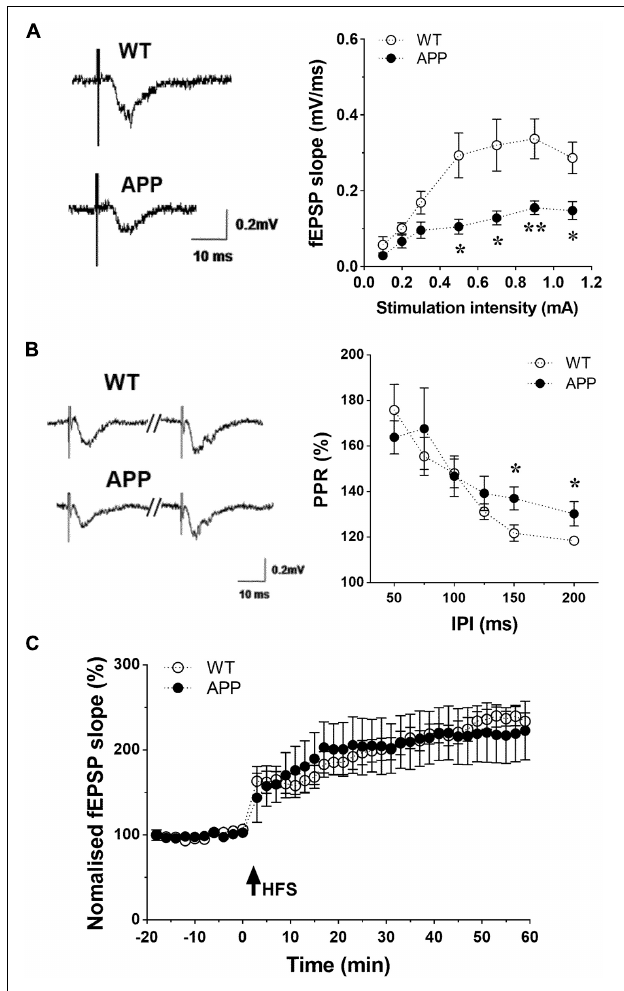
FIGURE 7 | Impaired hippocampal synaptic function in APP mice. (A) Basic synaptic transmission impaired in hippocampal CA1 region of APP mice. Input/output curve: Slopes of fractional changes in excitatory postsynaptic potential (EPSPs) were plotted against stimuli ranging from 0.1 to 1.1 mA. (B) Paired-pulse ratios (PPR, %) of fEPSPs were plotted against various interpulse intervals (IPI) ranging from 50 to 200 ms. PPR at the Schaffer collaterals-CA1 synapse were unchanged with IPI from 50 to 125 ms, but enhanced with IPI from 150 to 200 ms in APP mice compared to WT. (C) Induction of LTP by high frequency stimulations (HFS)-100p (100 Hz at 100 pulses) in hippocampal slices obtained from WT and APP mice (* p < 0.05, ** p < 0.01; two-tailed unpaired t -test n =